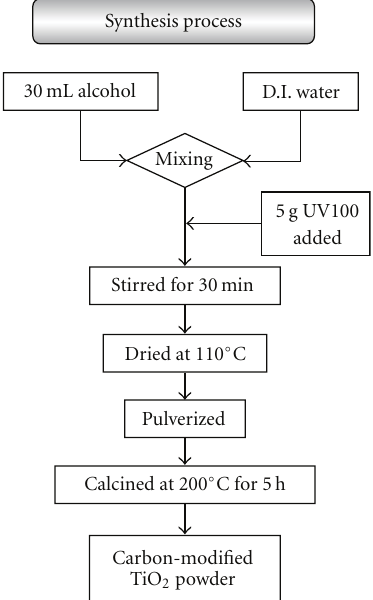
Figure 1: Schematic procedure for synthesis of carbon-modified TiO 2 powder by impregnation